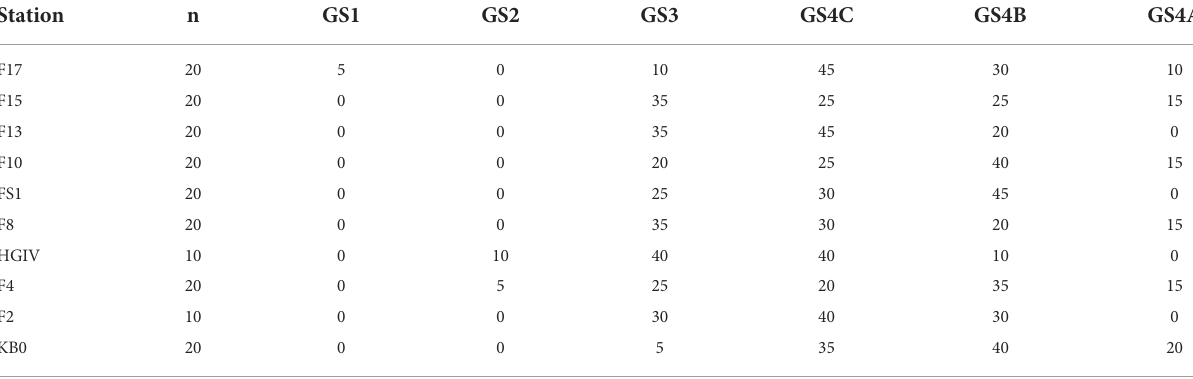
TABLE 2 Gonad maturation stages of female C. fi nmarchicus .